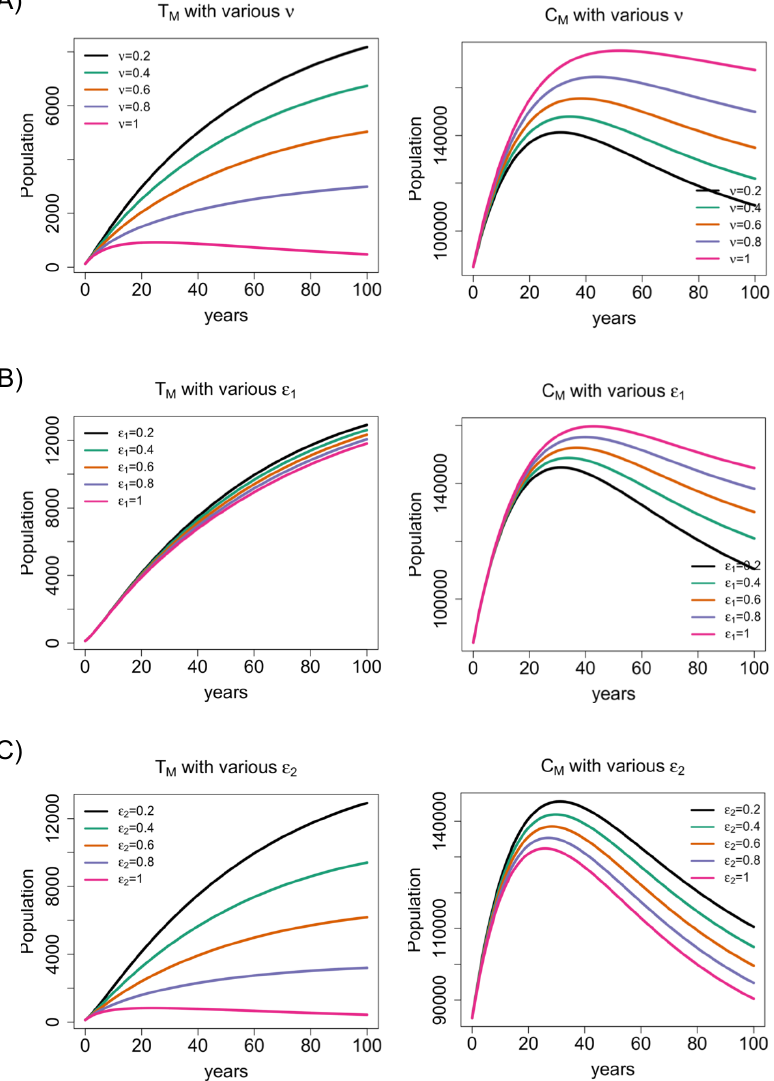
Figure 1. Numerical simulations of thalassemia and carrier population with the initial data G M = G C = 15,350, T M = 120, T F = 100, S M = 100,000, S F = 100,000, = 16,040, G F = G C M F C M = 85,000, C F = 90,000, U 1 = 15,000, U 2 = 30,000, and U 3 = 5000 and parameter values in Table 1. The value 0.2 means 20% rate and 1 100% rate in the legend. ( A ) Under various mar- riage reconsideration rates ( ν ). ( B ) Under various chances ( ε 1 ) of normal-to-carrier marriage. ( C ) Under various chances ( ε 2 ) of carrier-to-normal